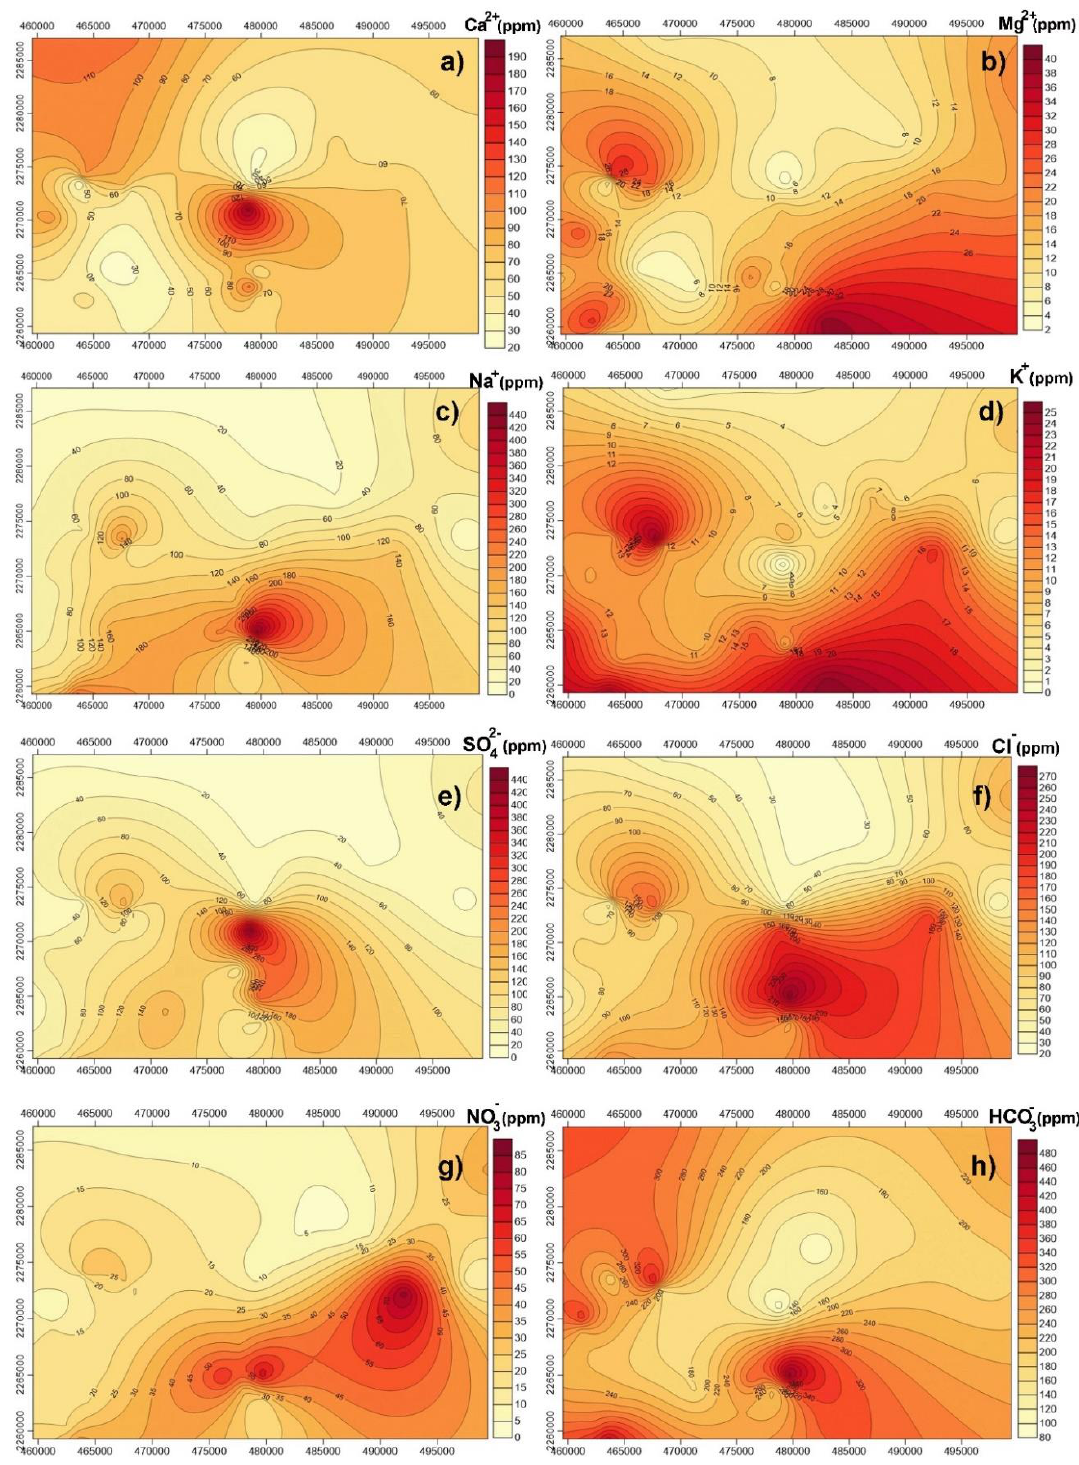
Figure 6. Spatial distribution map of cations ( a ) Ca 2+ , ( b ) Mg 2+ , ( c ) Na + , and ( d ) K + , as well as anions ( e ) SO 42 − , ( f ) Cl − , ( g ) NO 3 − , and ( h ) HCO 3 − in the study area.